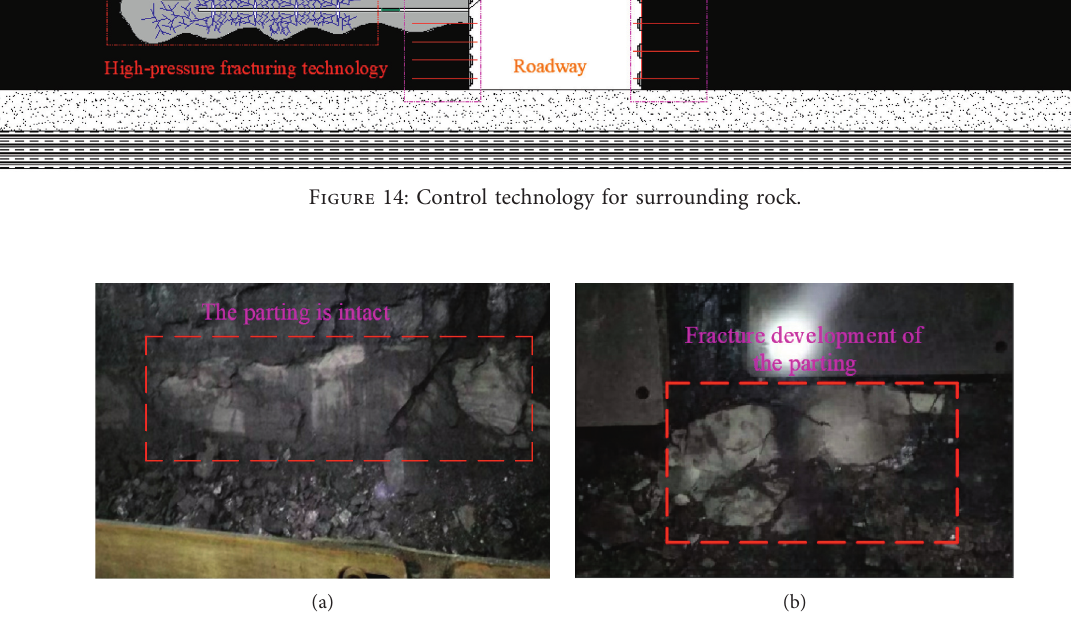
Figure 15: The parting before and after fracturing at the working face. (a) Before fracturing. (b) After fracturing.